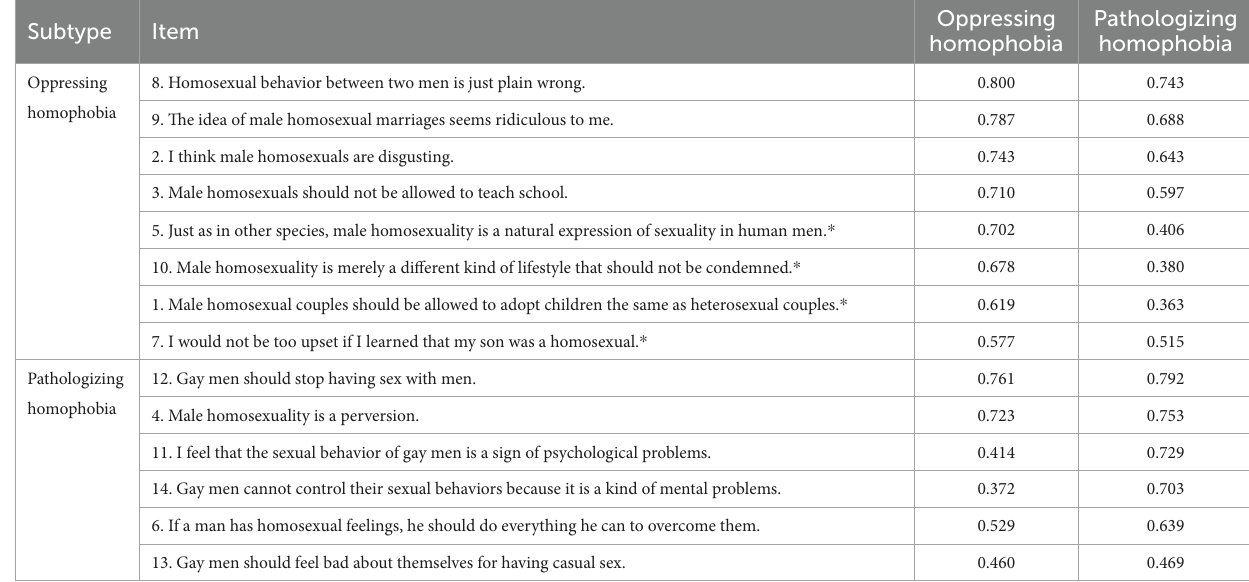
TABLE 2 Two subtypes of